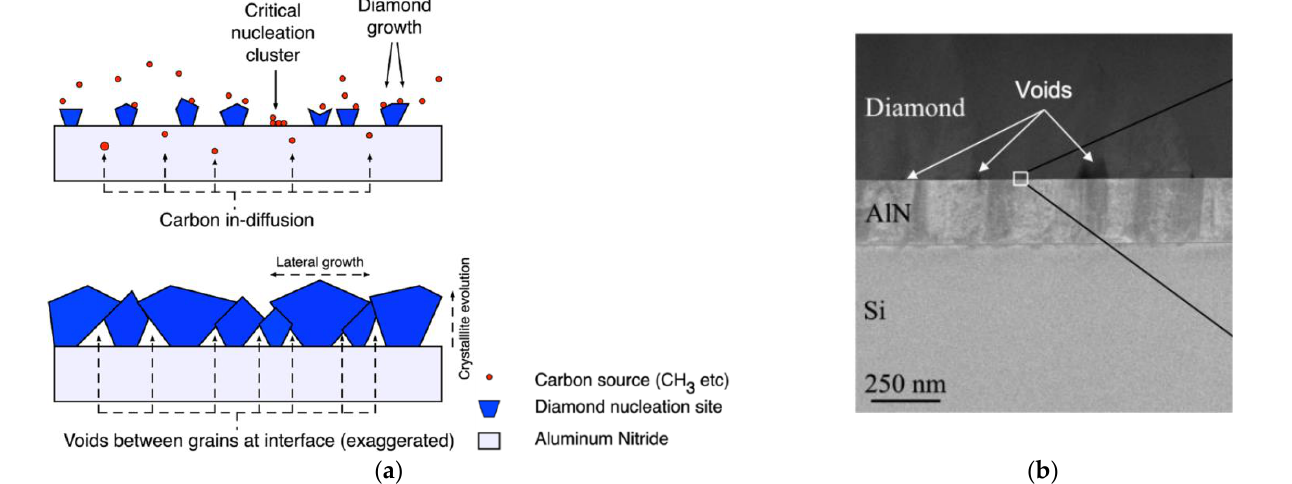
Figure 22. ( a ) Schematic of diamond film growth with low nucleation density; ( b ) HAAD-STEM image of the interface where the voids are clearly seen (reprinted from [84]; permission conveyed through CCBY 4.0.).